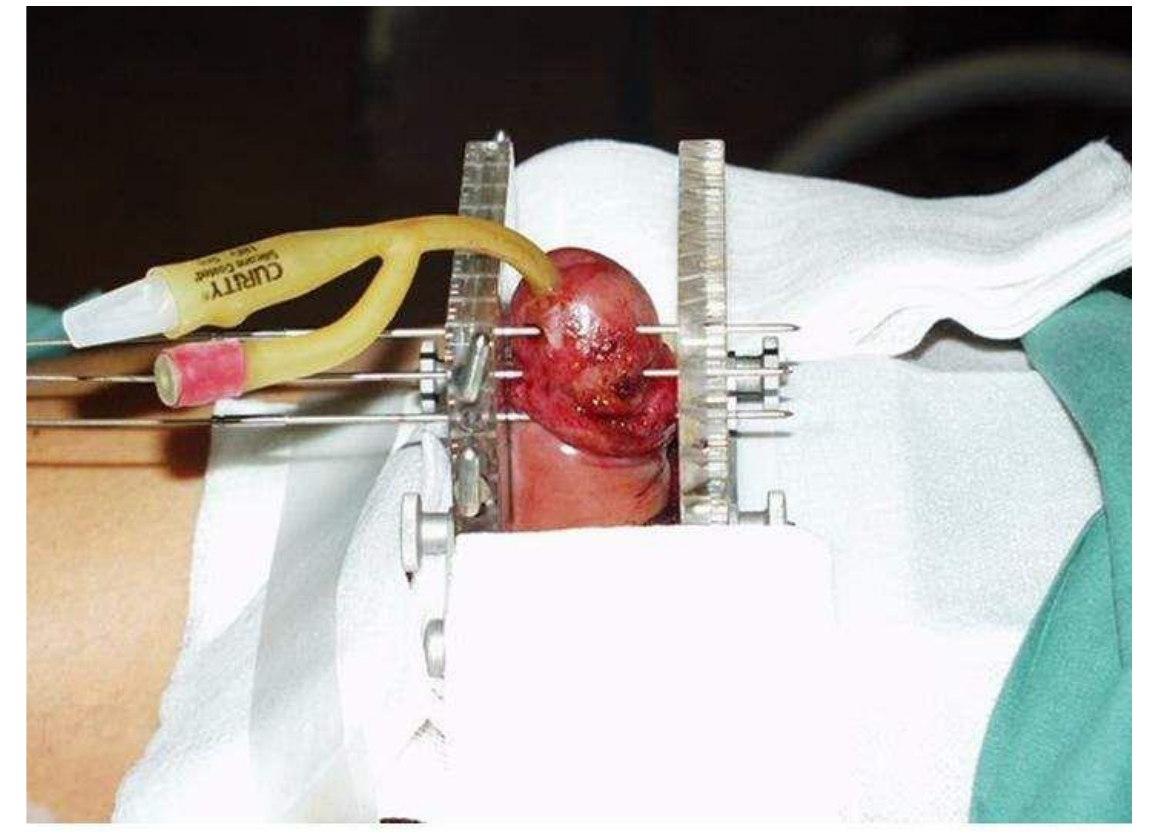
Figure 1. Implantation technique.